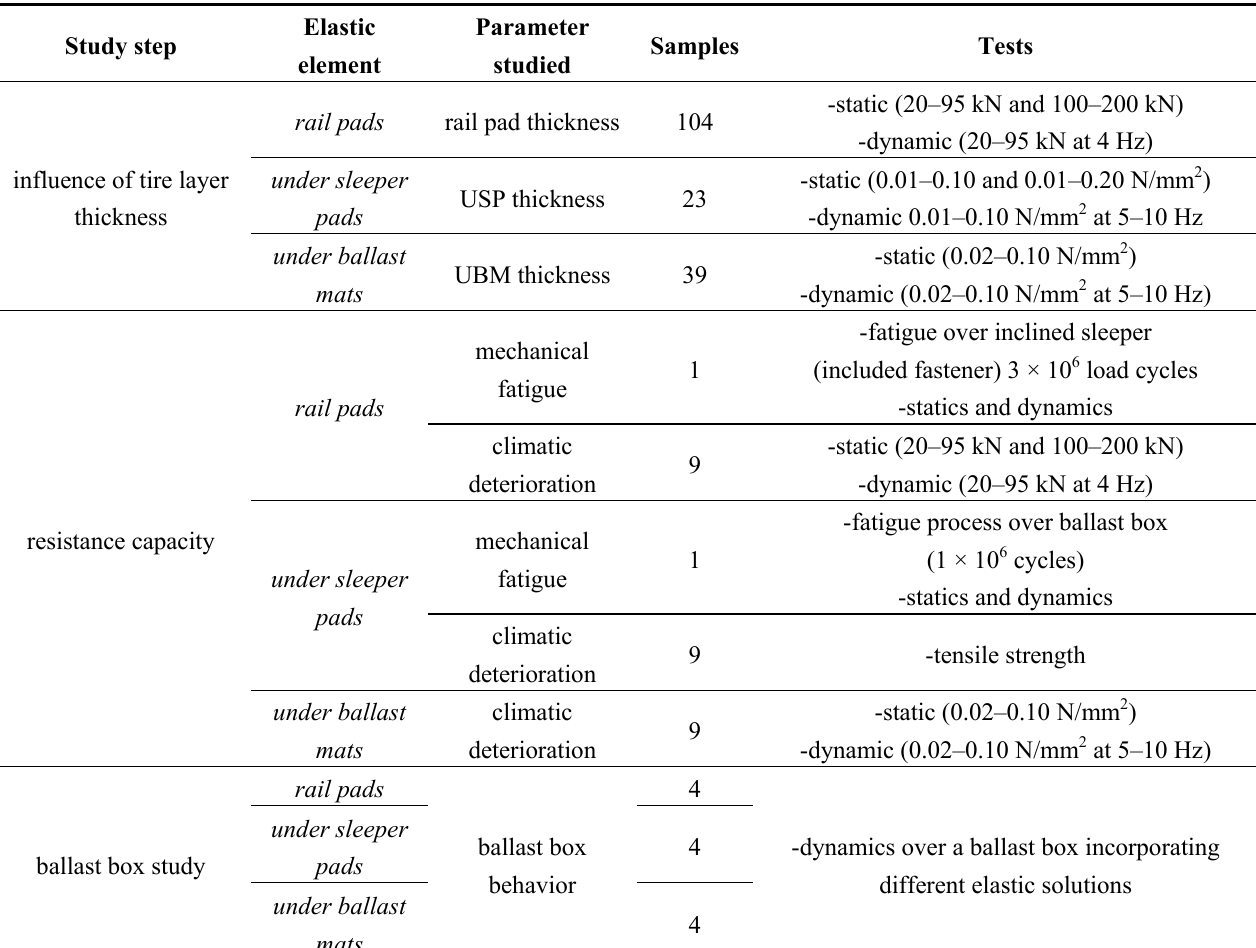
Table 2. Test planning